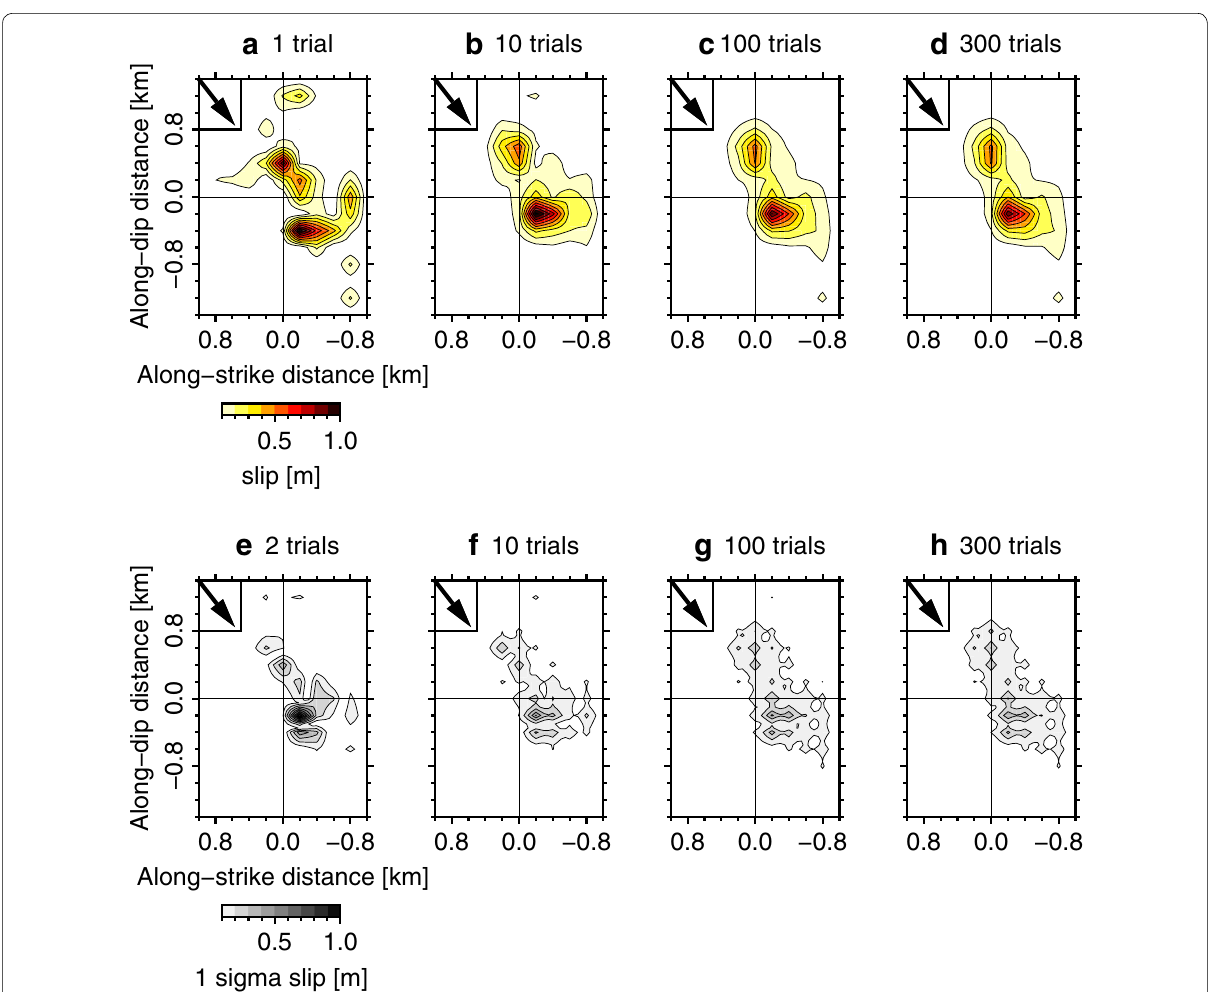
Fig. 3 Bootstrap method. The total slip distribution of M2005 in the Kushiro-Oki region after a 1 b 10, c 100, and d 300 trials. The standard deviation of slip distribution after ( e ) 2, ( f ) 10, ( g ) 100, and ( h ) 300 trials. The contour interval is 10 cm. The black arrow at upper left shows the slip direction from the F-net data.